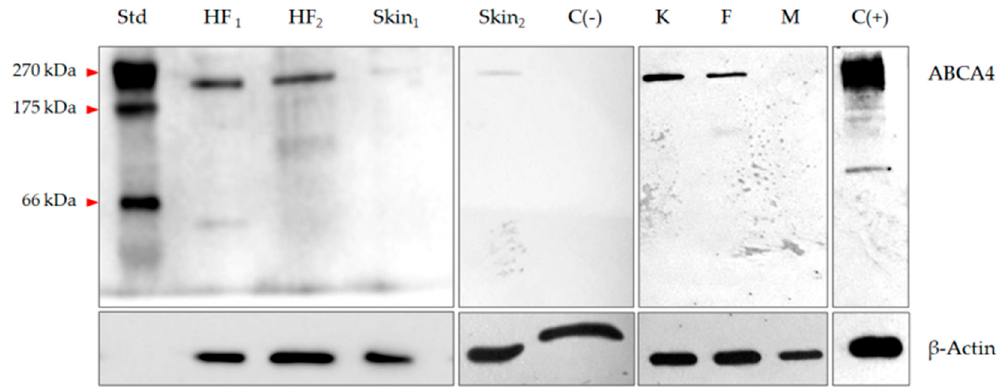
Figure 2. Expression of the ABCA4 gene in hair follicles, skin cells and skin lysates measured at the protein level with Western blot assay. HF, hair follicle; Skin, skin sample positive for ABCA4 mRNA; K, keratinocytes; F, fibroblasts; M, melanocytes; C(+), retinoblastoma lysate; C(–), skin sample negative for ABCA4 mRNA; Std, broad-range protein standard.